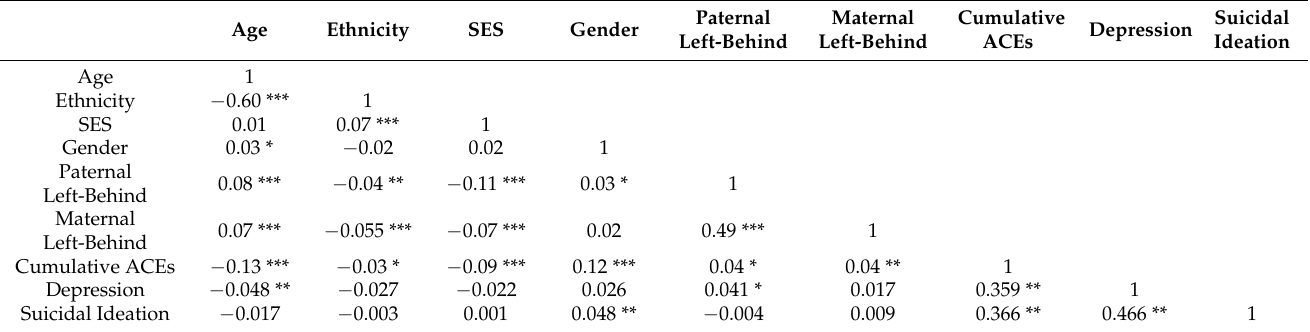
Table 1. Correlation Coefficients Among